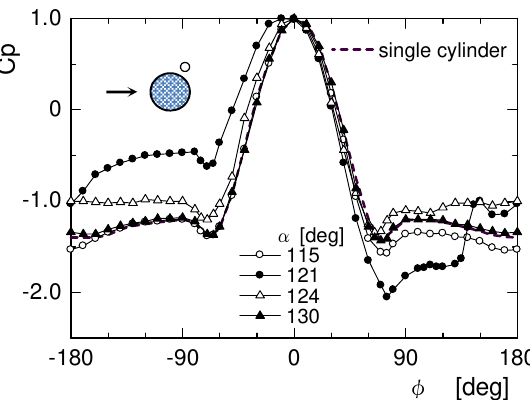
Fig. 5. Pressuer distribution of the circular cylinder for each